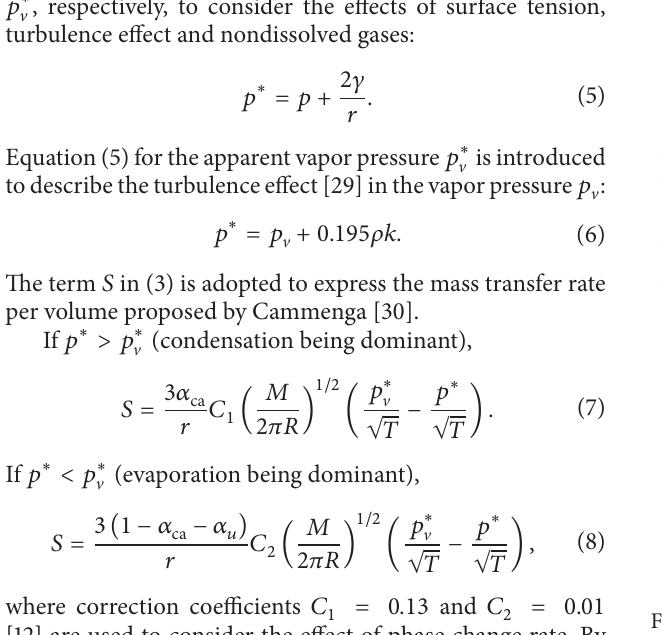
Figure 3: Produced power and comparison between prediction and